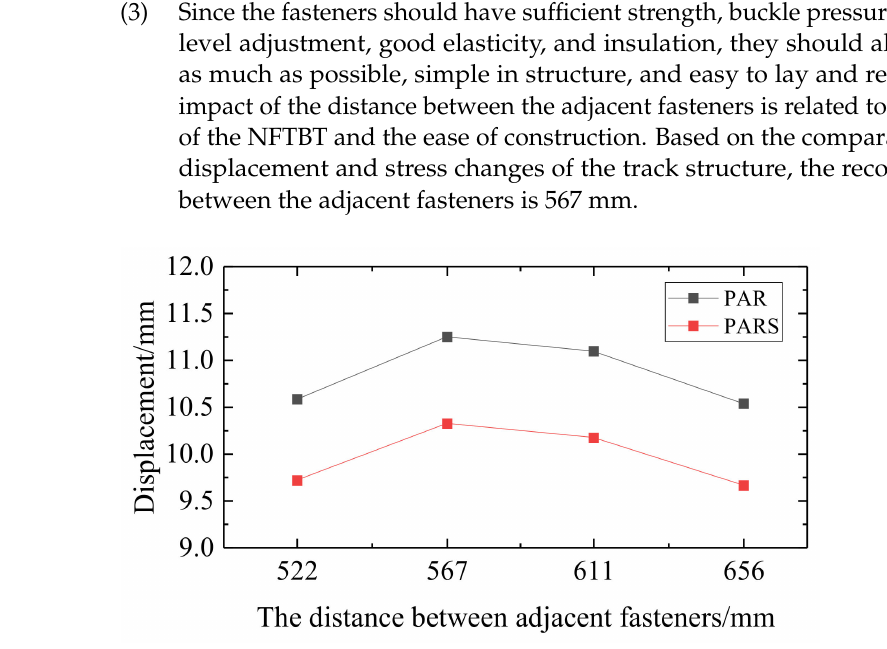
Figure 26. Displacement curve of NFTBT’s structure under the different distance between adja- cent fasteners.